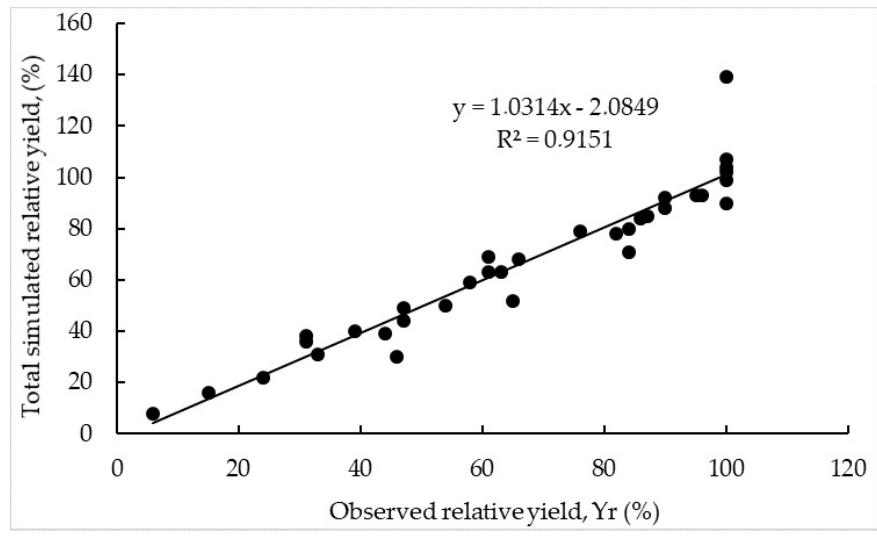
Figure 5. Relationship between total simulated and observed relative yield values (%) for all crops. Recurring to decimal logarithms, from analytical exponential expressions, a linear simple relationship of soil total water potential Ψ t (matric Ψ m + potential Ψ o) function and crop relative yield was studied and developed, according to Equations (22)–(24). The process is displayed by a flowchart that is given below (Figure 6).